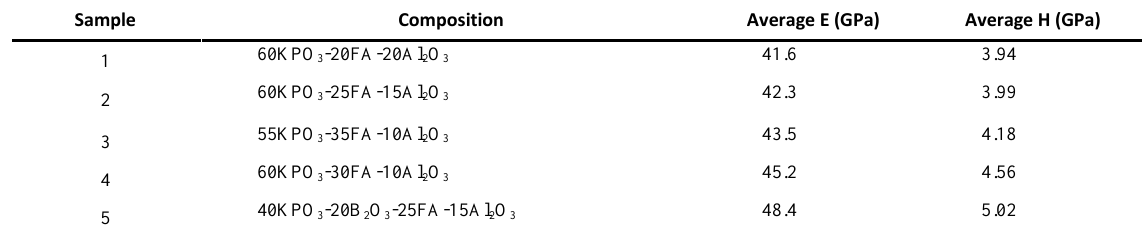
Table 6: Average elastic modulus and hardness of the samples of Series 2 consisting of fly